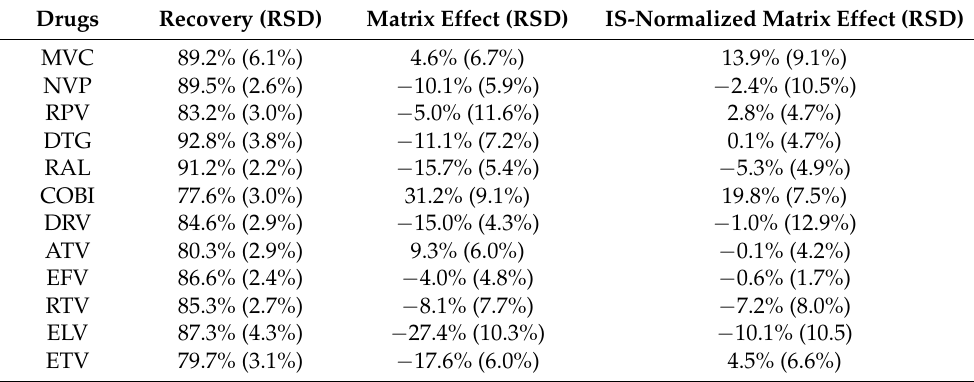
Table 3. Mean recovery and mean matrix effect for all